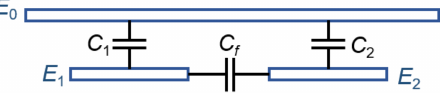
Figure 1. Schematic of a capacitive spacing